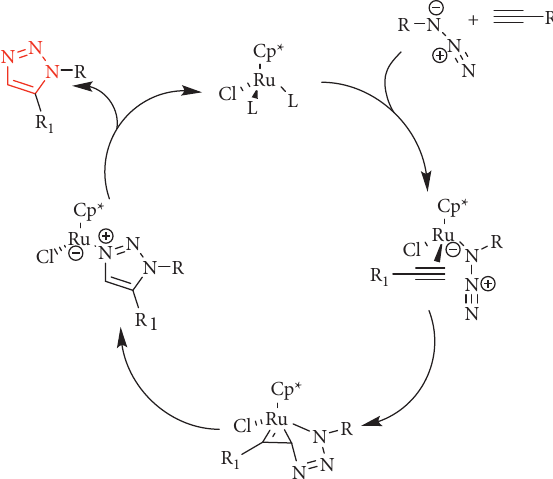
Scheme 8: Mechanism of the ruthenium-catalyzed azide-alkyne cycloaddition